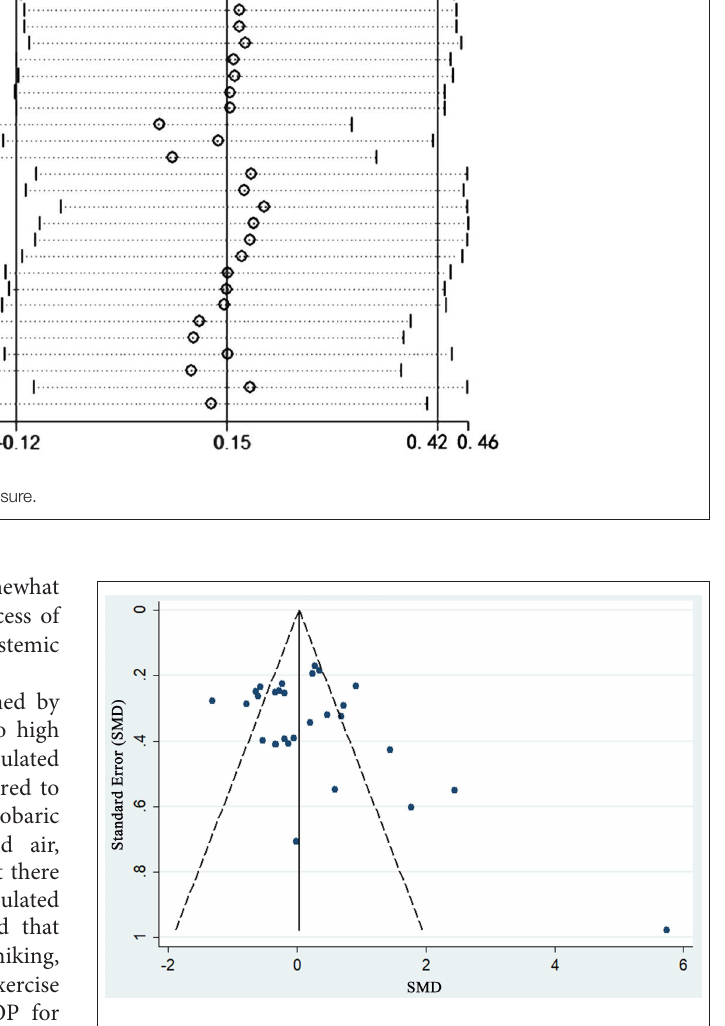
FIGURE 8 | Funnel plot of changes in IOP during high altitude